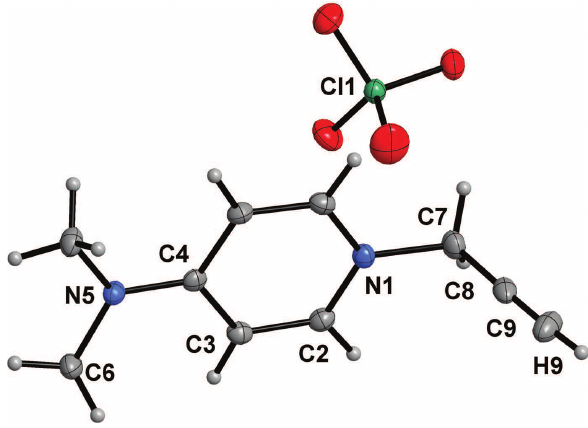
Table 2: Fractional atomic coordinates and isotropic or equivalent isotropic displacement parameters (Å 2